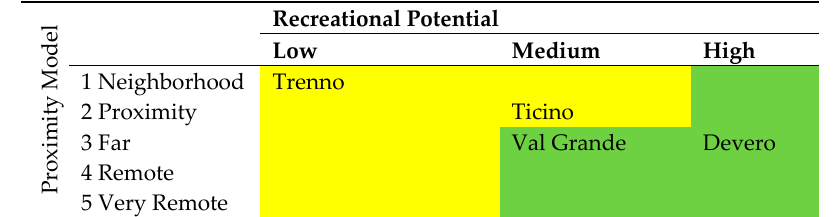
Table 1. Classification of the four settings according to the ROS classes and corresponding biophilic quality (BQ): The red line separates settings with low BQ (Trenno and Ticino, yellow background) from settings with high BQ (Val Grande and Devero, green background). Note: Ticino and Val Grande show